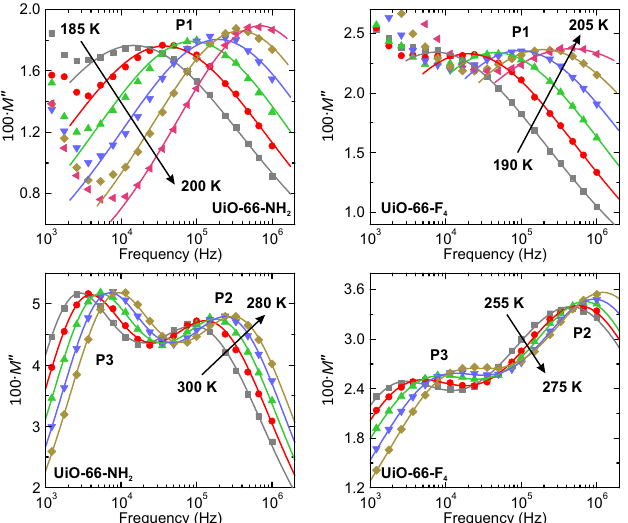
Figure 4. Frequency dependence of the imaginary part of the complex electric modulus of UiO-66-NH and UiO-66-F hydrated MOFs presented at selected temperatures. Relaxation processes are indicated 4 by the labels. Solid lines the best fits to the Cole-Cole relaxation